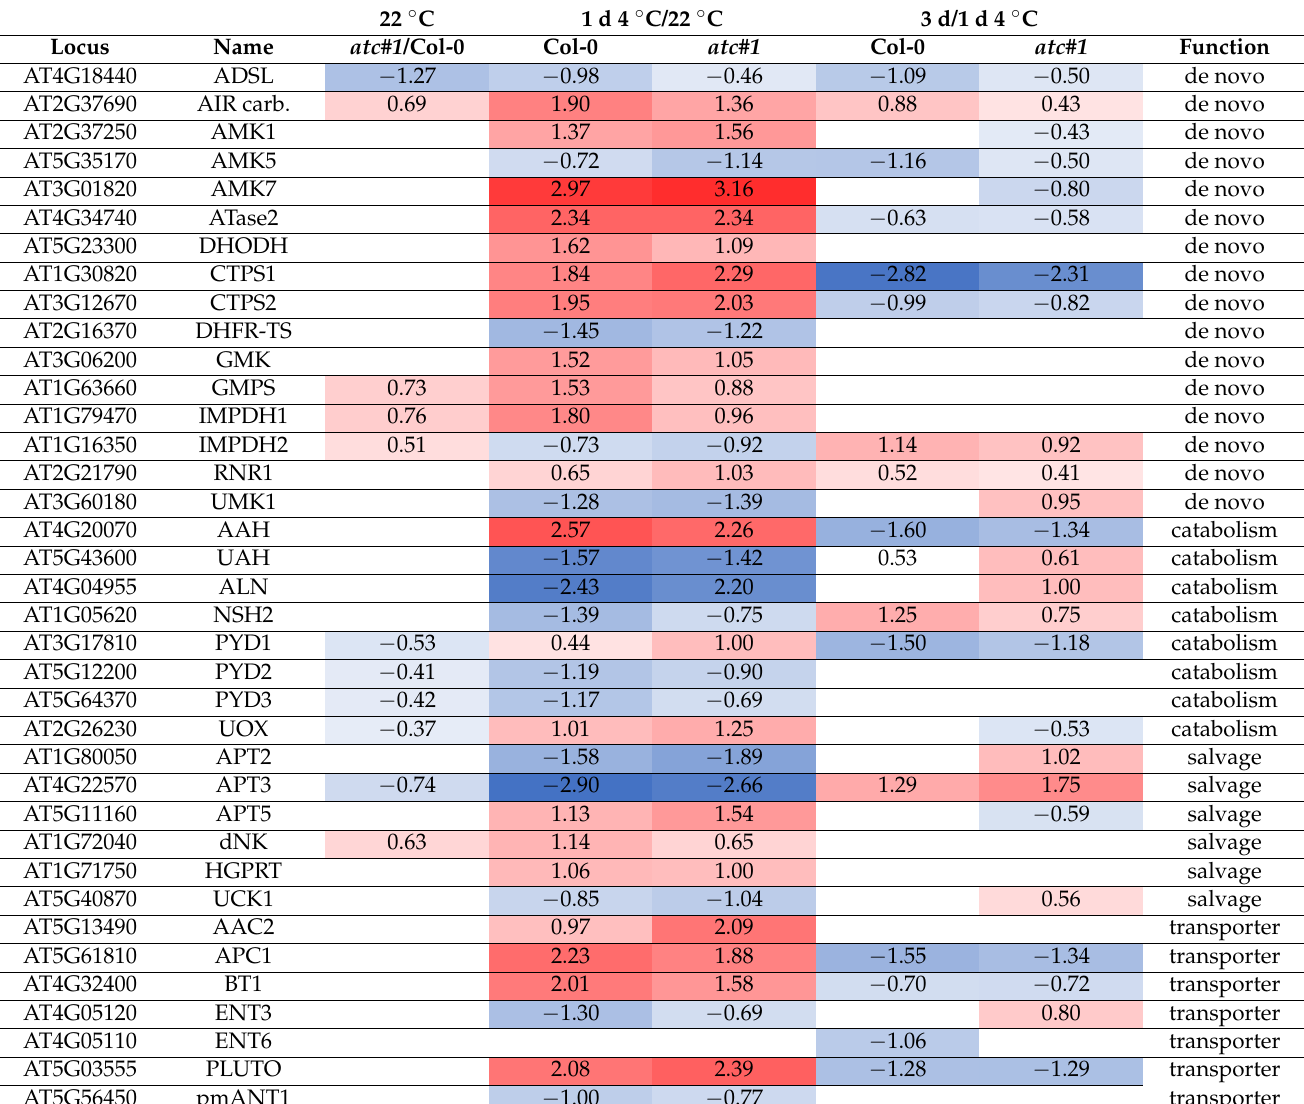
Table 1. DEGs involved in nucleotide metabolism. Selected genes (p adj. < 0.05) are shown. AGI, Arabidopsis genome